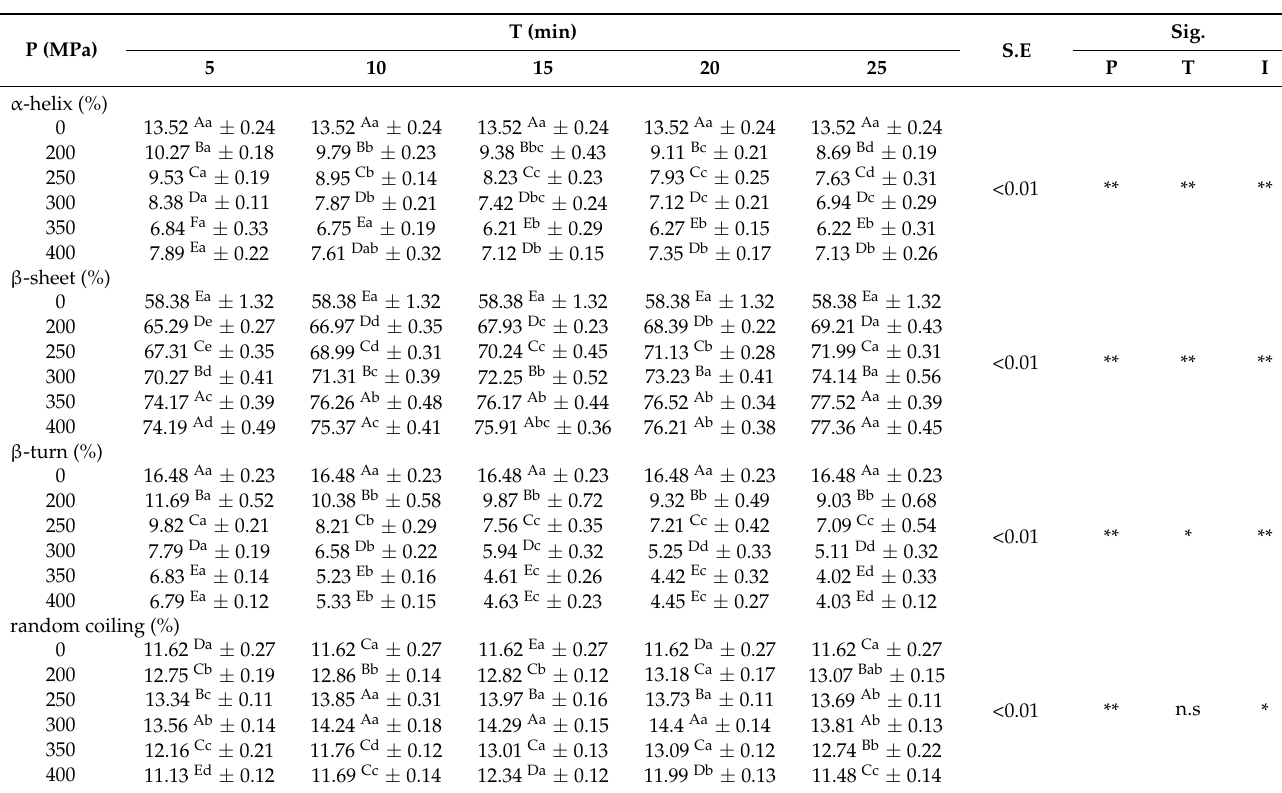
Table 1. Effect of high hydrostatic pressure on the secondary structure content evaluated from deconvoluted FTIR spectra of cowhide